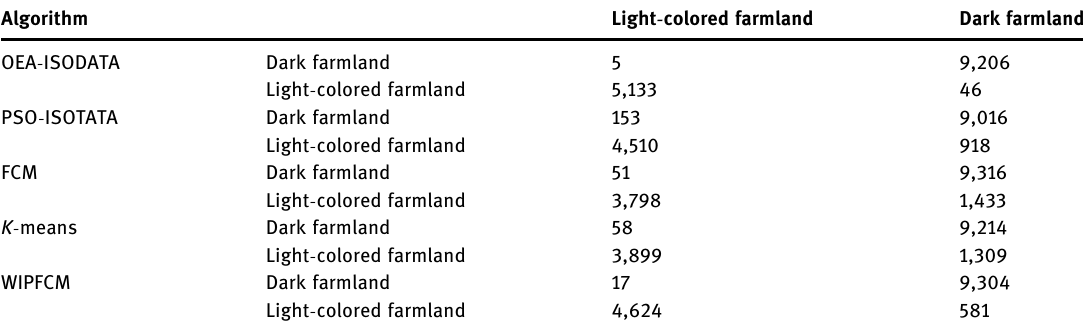
Table 1: Comparison of segmentation results of di ff erent algorithms for farmland SAR image Algorithm